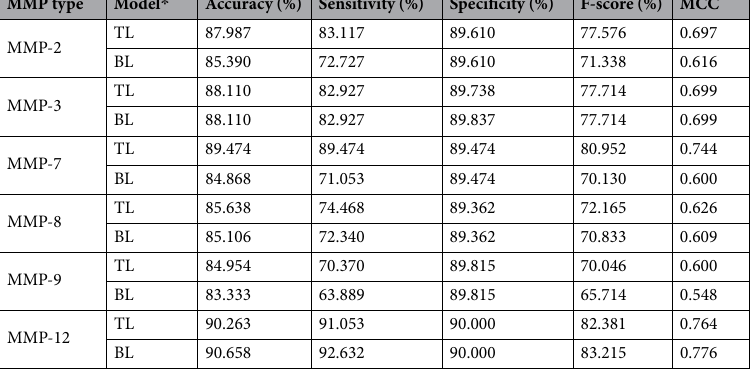
Table 2. Predictive performance of the transfer-learning method and baseline method evaluated based on the five-fold cross validation tests. * Model: TL, Transfer-learning method; BL, Baseline method.